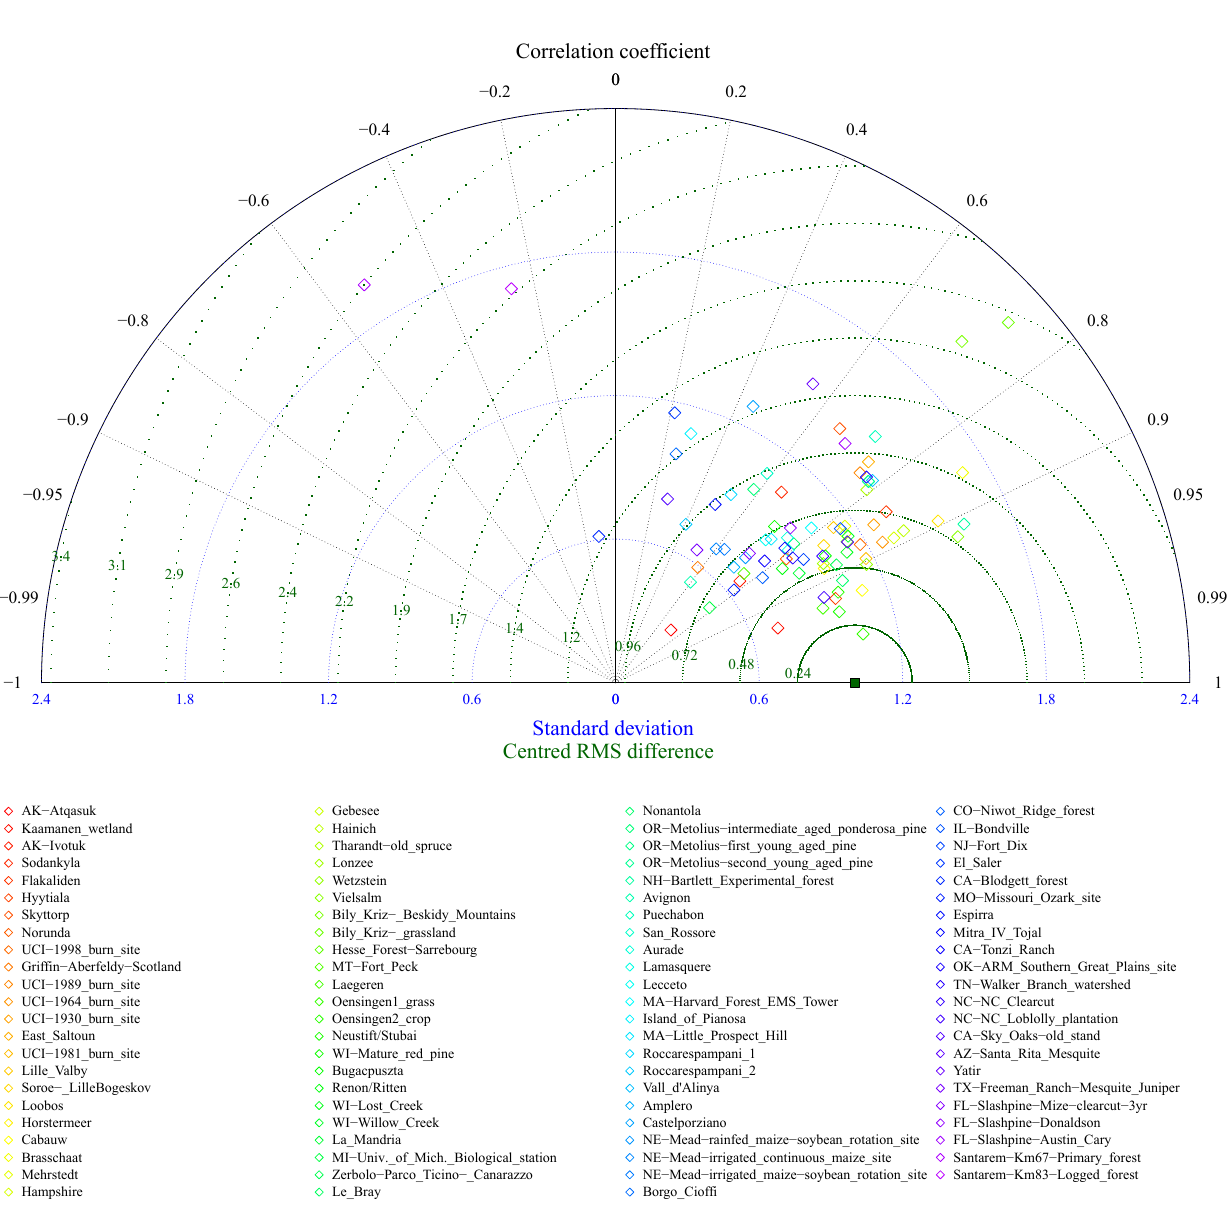
Figure 7. Evaporation rate measured at eddy flux towers: ORNL DAAC (2011). Available online at FLUXNET (http://fluxnet.fluxdata.org/ data/la-thuile-dataset/). Site locations are ordered from north to